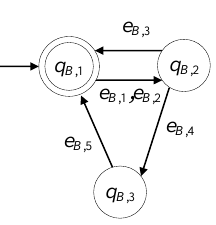
Figure 5. The state diagram of G B .